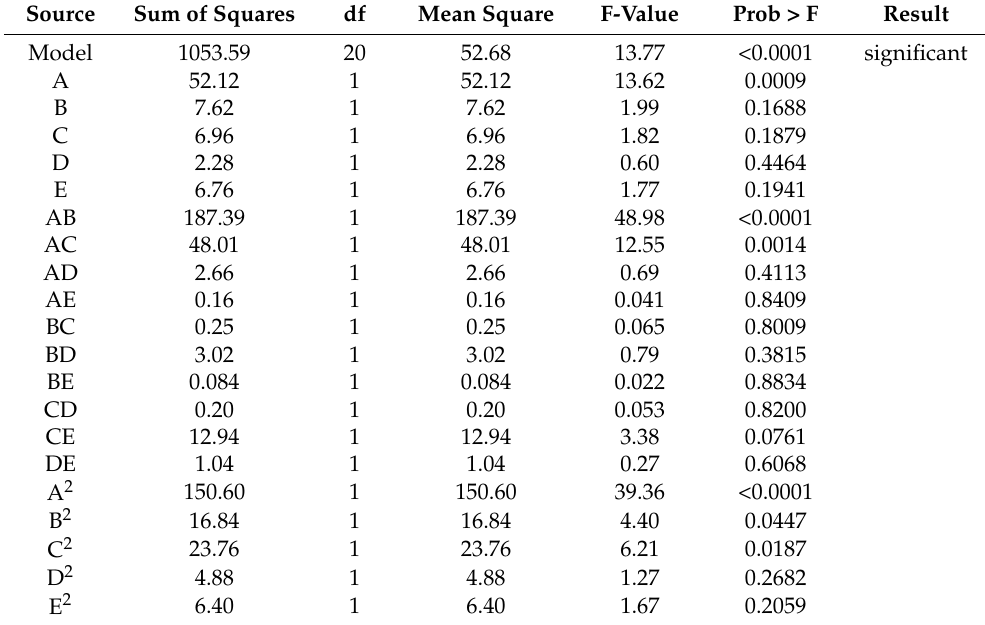
Table 7. Significance test of the impact degree regression